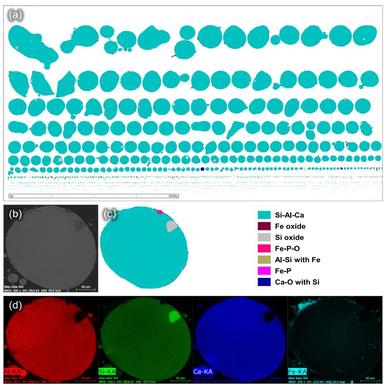
Phase distribution map of the IGCC slag that was obtained by the automated SEM-EDS system and MLA. (a) The Si-Al-Ca phases were predominant over a broad size range. (b) The Si-Al-Ca spheres had a homogeneous composition contrast and contained silica and iron oxide phases. (d) The concentration of the major elements, namely, Al, Si and Ca, were evenly distributed in the particle.